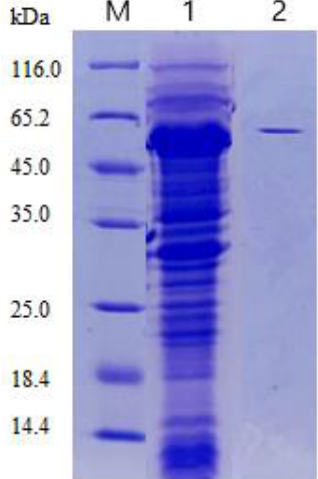
Figure 2. SDS-PAGE analysis of recombinant agarases from Brevibacillus . Lane M: low-molecular-weight marker; Lane 1: crude enzyme solution of recombinant enzyme Aga-ms-R; Lane 2: purified recombinant enzyme Aga-ms-R.